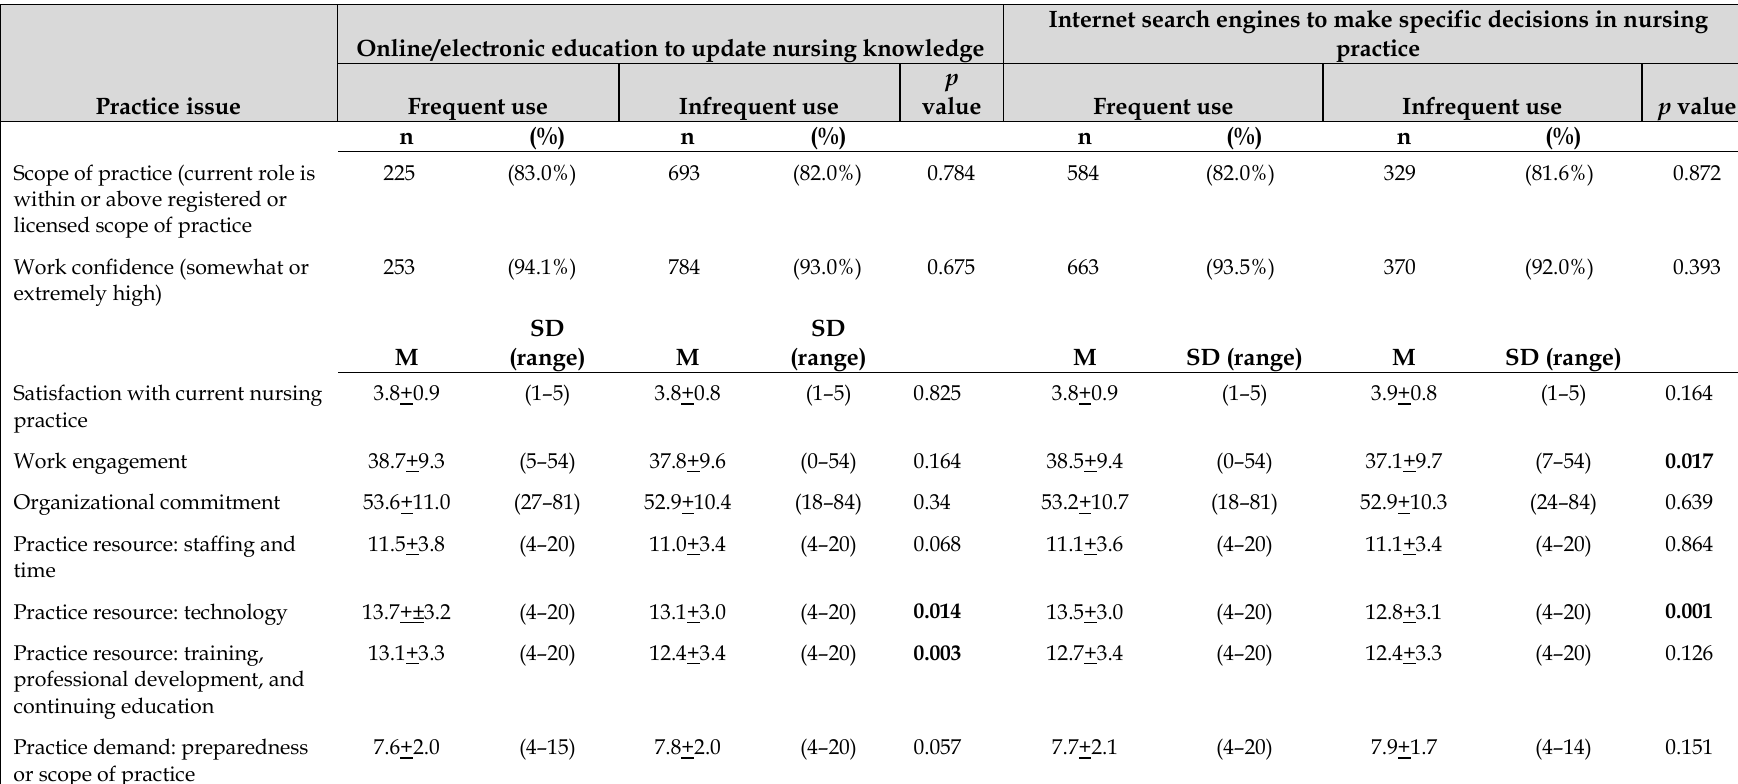
Table 7 Practice issues among licensed practical nurses (LPNs) by frequency of online/electronic education and Internet search engine